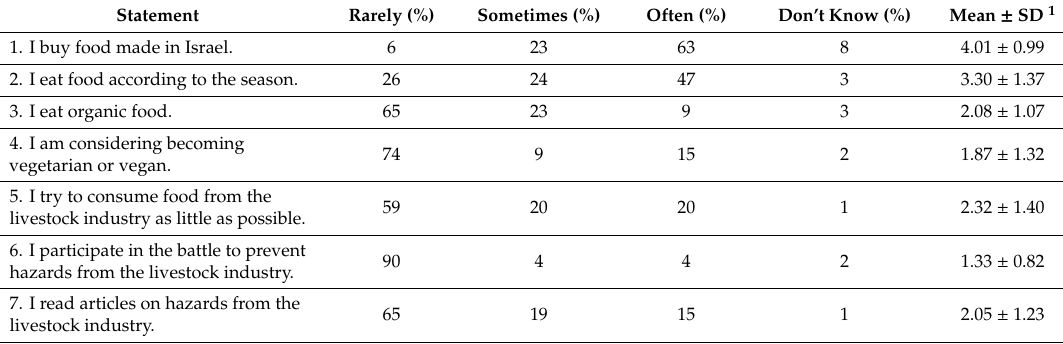
Table 4. Distribution of responses to the behavior